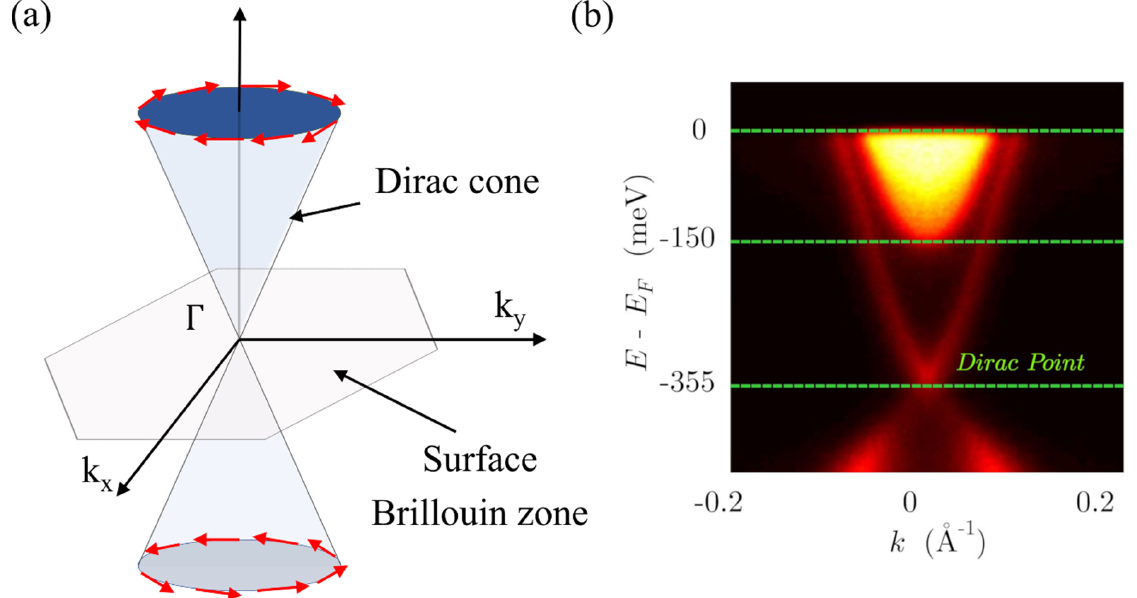
Figure 1. ( a ) Scheme of a Dirac cone at the surface of a Topological Insulator (TI) showing the spin-momentum locking (spin orientations are indicated by red arrows). ( b ) Angle-Resolved Photoemission Spectroscopy (ARPES) image of the Bi 2 Se 3 band structure showing the Dirac cone at the center of the Brillouin zone. Reprinted with permission from Reference [7]. Copyright 2010 American Physical Society.